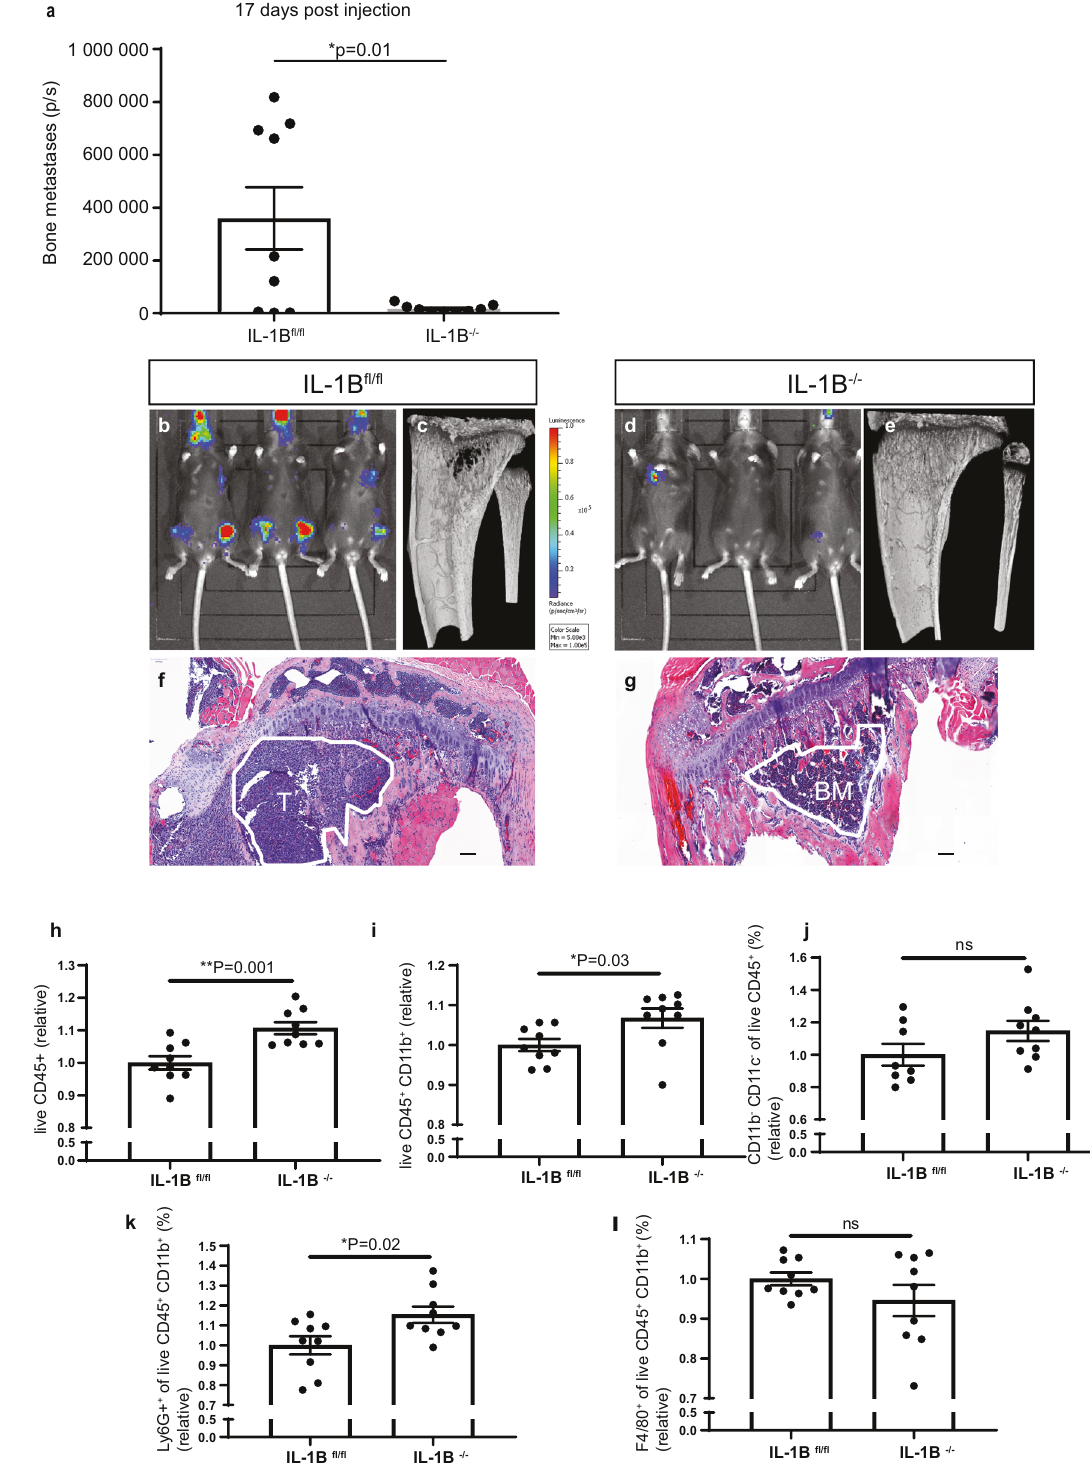
Fig. 5 Microenvironment-derived IL-1B drives breast cancer bone metastases by controlling myeloid cell abundance. a Quanti fi cation (photons/seconds) of bone metastases in IL-1B fl / fl and IL-1B − / − mice after intra-cardiac administration of E0771 luc2 V5 GFP tumour cells. b Representative bioluminescence micrographs of metastases in bone and distant locations in IL-1B fl / fl mice. c µCT scans and f H&E staining of tibia in tumour-bearing IL-1B fl / fl mice. Scale bar = 100 µm. d Representative bioluminescence micrographs of metastases in bone and distant locations in IL-1B − / − mice. e µCT scans and g H&E staining of tibia in tumour-bearing IL-1B − / − mice. H&E images: BM bone marrow, T tumour. Data are mean ± SEM, Two-tailed unpaired t -test with Welch ’ s correction. Relative percentage of h immune cells (CD45 + ), i myeloid cells (CD45 + CD11b + ), j lymphoid cells (CD45 + CD11b − CD11c − ), k neutrophils (CD45 + CD11b + Ly6G + ) and l macrophages (CD45 + CD11b + F4/80 + ) in bone marrow samples from femurs of IL-1B fl / fl ( n = 9) and IL-1B − / − ( n = 9) mice detected using multicolour fl ow cytometry. Data are mean ± SEM, Two-tailed unpaired t